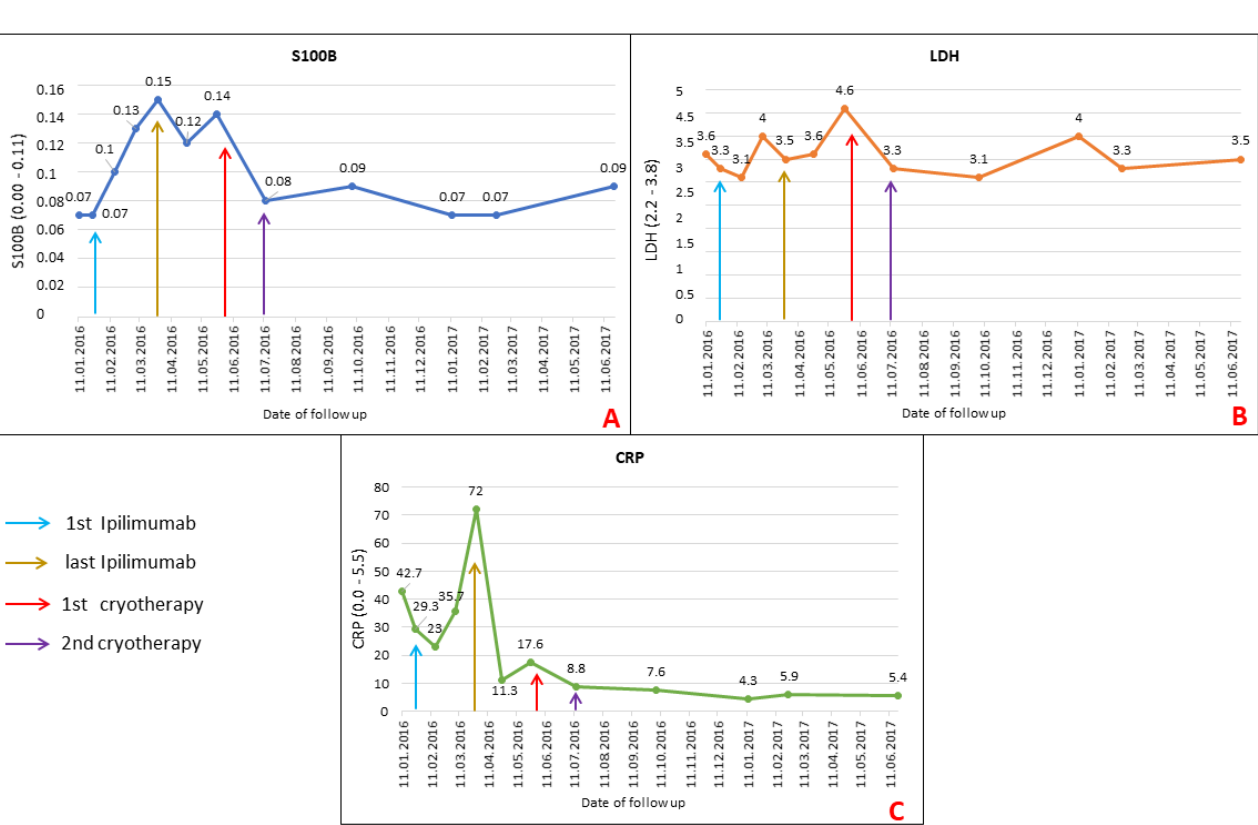
the elevation of S100B during clinical worsening and progression of metastatic disease at the ipilimumab therapy and the normalization of S100B values after cryotherapy. Similar results and values were observed for LDH ( Graph B ). In the case of CRP, significantly lower values were observed after completion of ipilimumab therapy, despite significant clinical progression ( Graph C ).